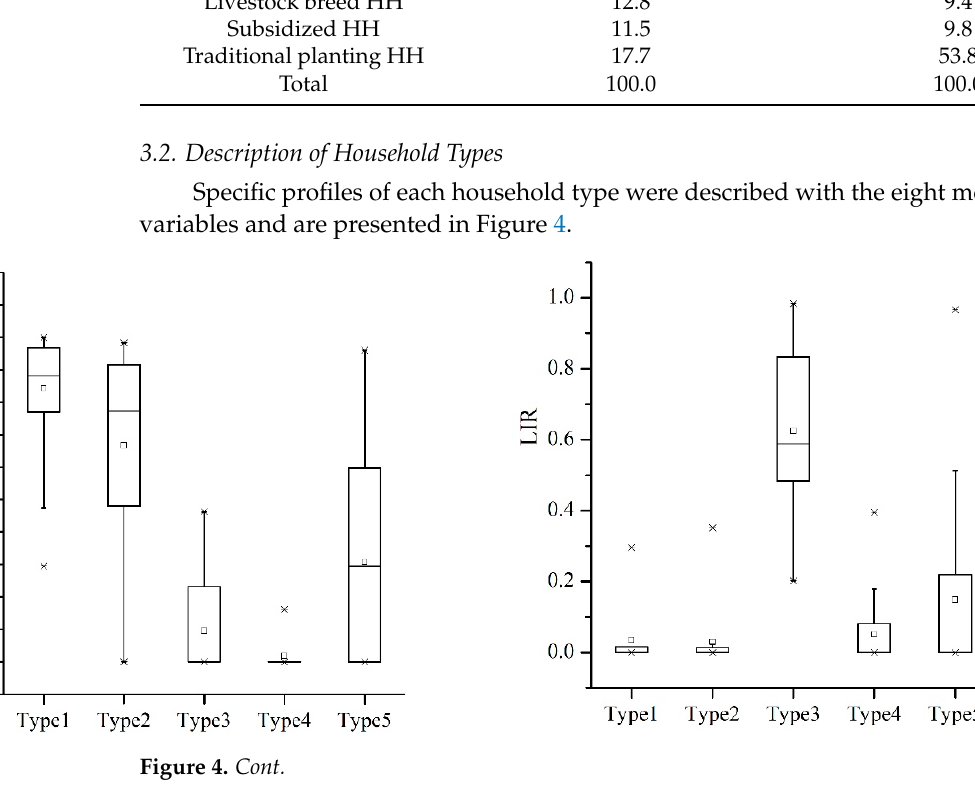
Figure 3. Household type definition. Note: ‘HH’ is the abbreviation of ‘household’.